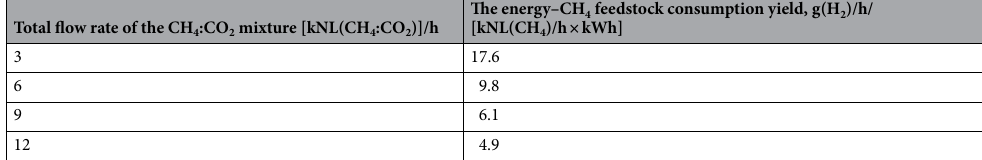
Table 3. The energy–CH 4 feedstock consumption yields for various total flow rates of the CH 4 :CO 2 mixture under the conditions: P